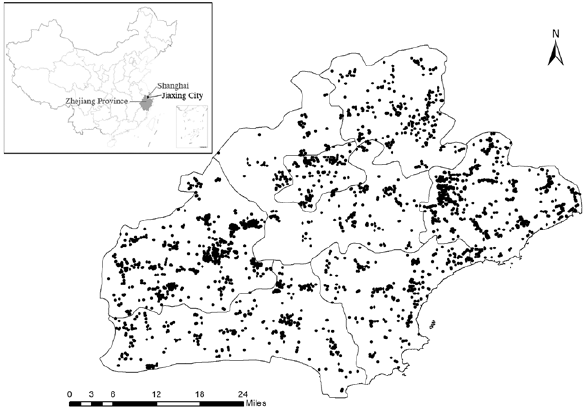
Figure 3. Location of Jiaxing City and industrial land plots obtained through transfer in Jiaxing from 1999 to